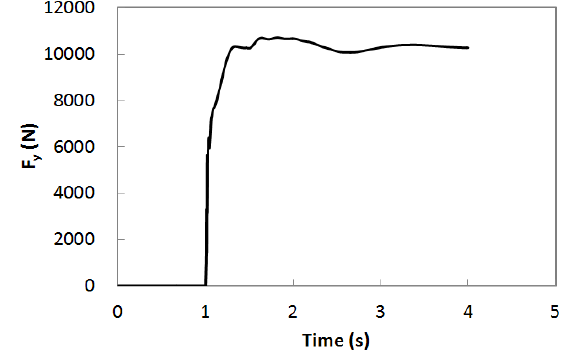
Figure 11. Total lateral